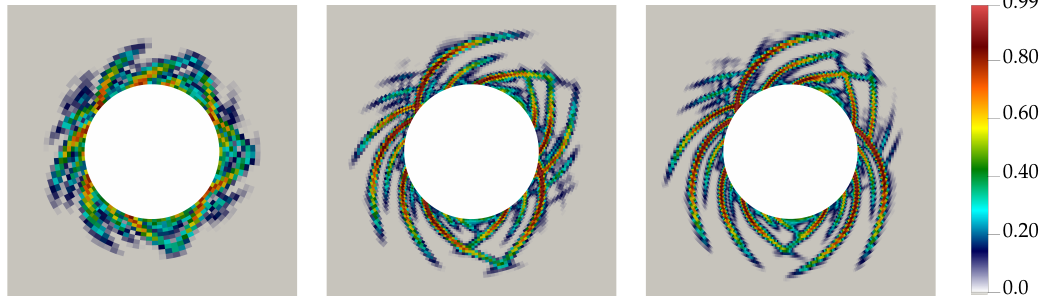
Figure 17. Distribution of the damage variable ω in the rock mass in the vicinity of the tunnel surface at the level of 12% of the internal pressure for the three finite element meshes employing full numerical integration: coarse ( left ), medium ( center ), and fine ( right